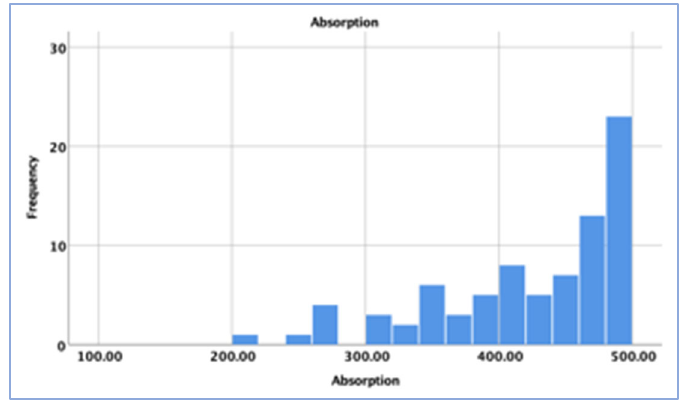
Figure 1. Distribution of Absorption Scores